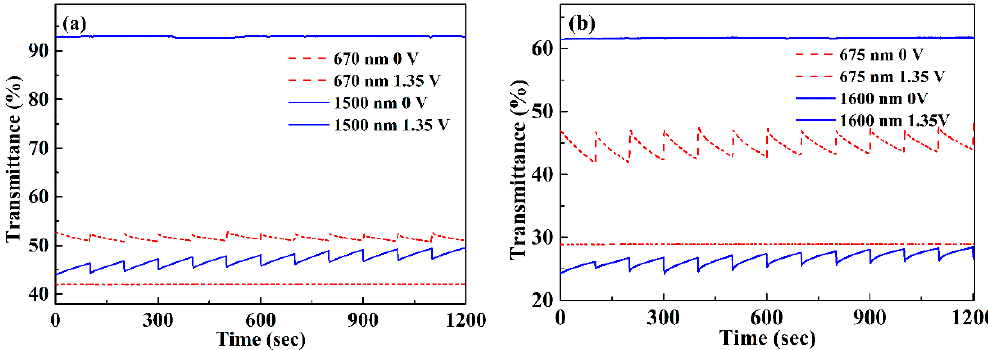
Figure 10. Open circuit stability of the sprayed films at 670 and 1500 nm for copolymer PITID-1 ( a ) and the film at 675 and 1600 nm for copolymer PITID-2 ( b ). The pulse voltage was applied for 1 s for every interval time of 120 s to recover the initial transmittance at constant neutral or oxidized state. Straight line: neutral state, Jagged line: oxidized state. Dotted line: 670/675 nm, Solid line: 1500/1600 nm.